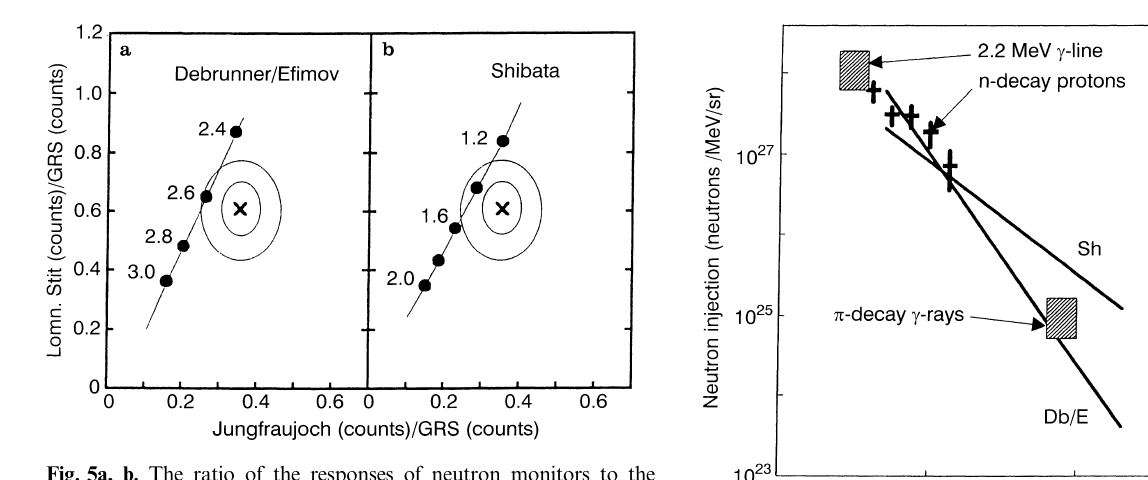
Fig. 5a, b. The ratio of the responses of neutron monitors to the response of the GRS instrument onboard the SMM spacecraft for the 3 June 1982 solar flare. The observed values are shown as crosses with 1 (cid:114) and 2 (cid:114) uncertainty ellipses . Lines correspond to calculated values of the ratio according to the IGY-D/NM64-E and IGY-Sh/NM64-Sh sensitivities ( a and b plots, respectively). The figures correspond to values of the G index of a power-law spectrum of solar neutrons